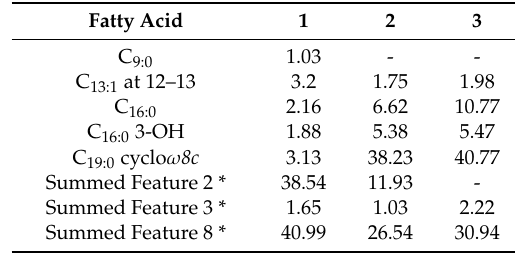
Table 2. Cellular fatty acid contents of strain M15 T and the type strains of related Rhizobium type species. 1, M15 T ; 2, R. radiobacter LMG140 T ; 3, R. pusense NRCPB10 T . All data were obtained in this study. Fatty acids representing < 1% in all strains were omitted. -, not detected.